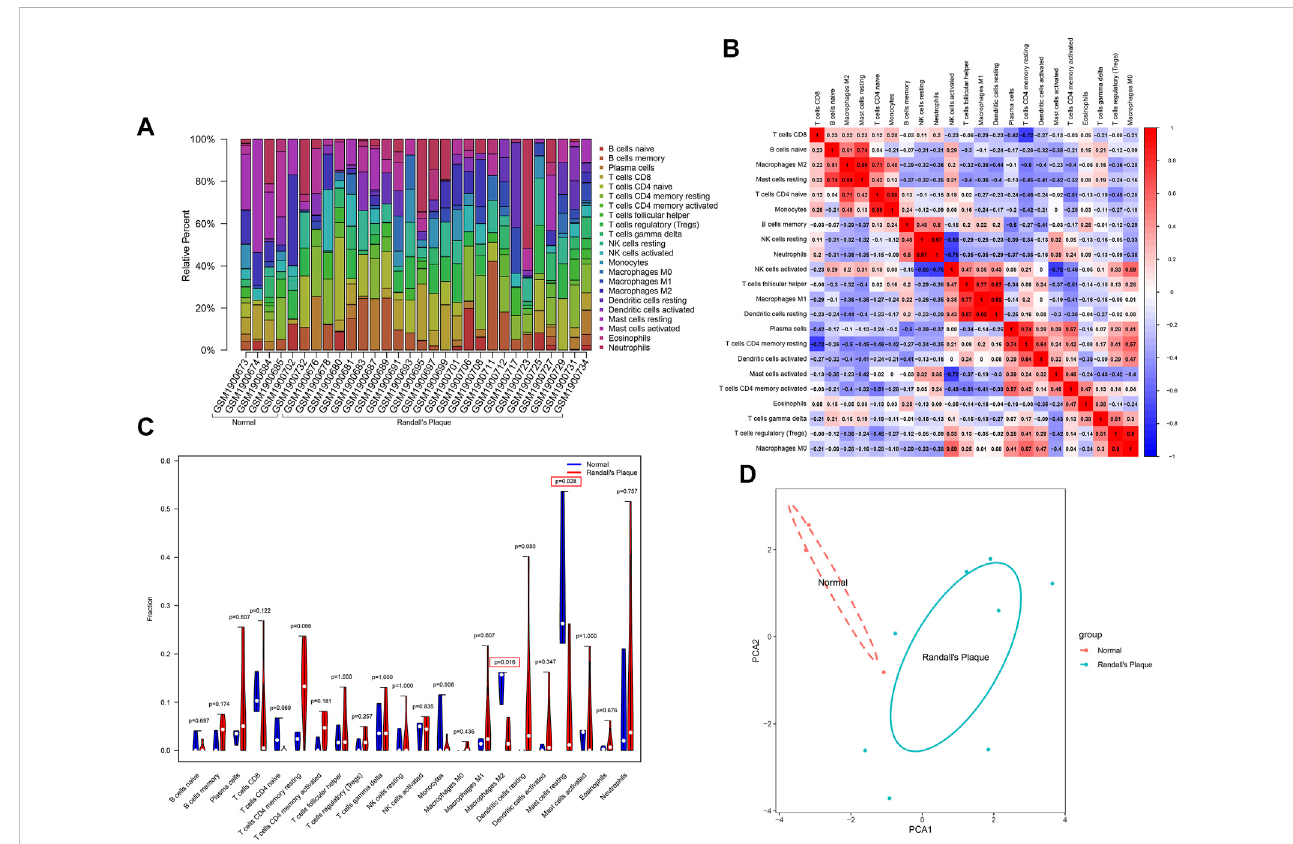
FIGURE 5 (A) CIBERSORT algorithm estimation of the percentages of 22 immune background cells in GSE73680. (B) Heatmap displays immune cell correlation among samples with p -values. (C) Violin plot shows immune cells in fi ltration statistical difference in normal and RP samples. (D) PCA analysis differentiates normal with RP